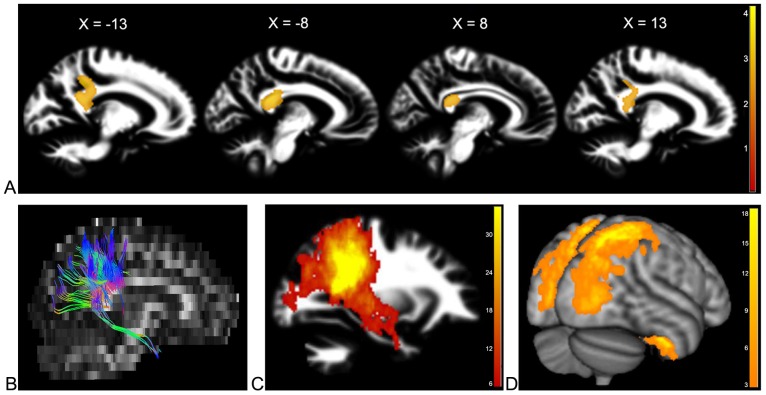
Imaging results.(A) Main association of rs917235 with white matter volume. Sagittal view of the significant cluster associated with rs917235 at the MNI coordinates of X = −13, −8, 8, and 13 mm relative to the midline. The background image is the average of all individuals' white matter segmented images. The colour-bar shows the z-scores of the statistical analysis. (B–D) Structural connectivity. (B) A sample of fiber tracking from one individual passing through the region associated with rs917235. Different colours show the direction of pathways (red for left-right, blue for superior-inferior, and green for anterior-posterior). (C) Overlay of tract tracing from 30 randomly selected individuals. The colour-bar is a count for the number of subjects; yellow shows the most probable pathways. (D) Cortical end-points of the white matter pathways showing that the fibers connect right postcentral gyrus, superior parietal lobule, precuneous, occipital cortex and temporal fusiform gyrus to the analogous left regions.